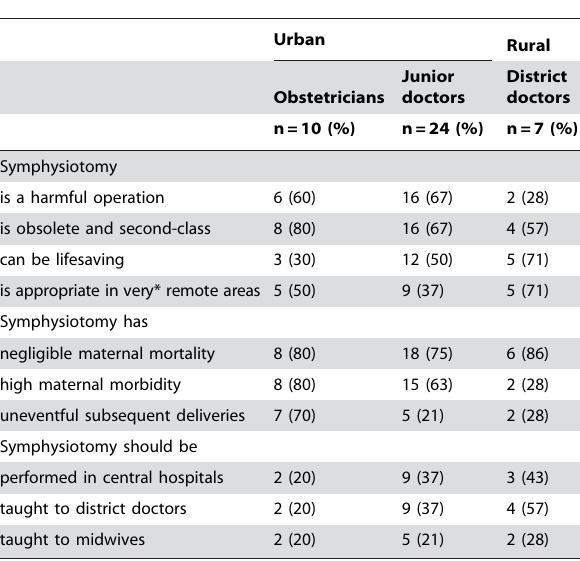
Table 5. Affirmative answers on statements